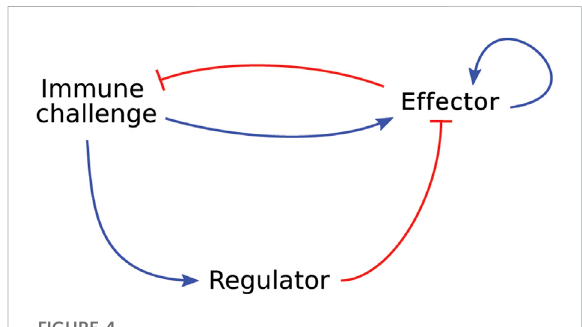
FIGURE 4 Graphical representation of the model developed by Sontag (2017), which describes a generic immune response in which an effector species and a regulatory species respond to an immune challenge. Blue arrow-heads indicate a stimulating relationship, red bar-heads indicate